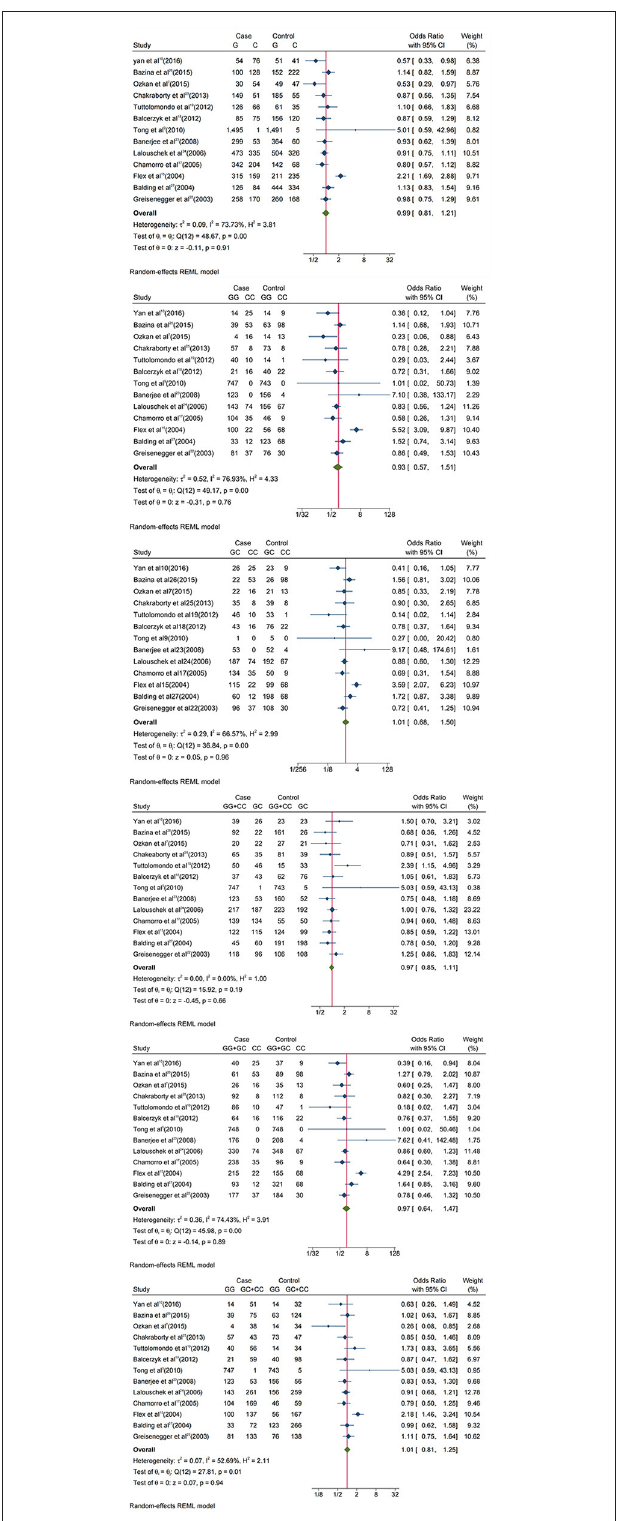
FIGURE 2 | Forest plots of Interleukin-6 − 174G/C(rs1800795) polymorphism and IS. The allelic comparison (G vs. C), homozygote comparison (GG vs. CC) and (GC vs. CC), hyperdominant (GG + CC vs. GC), recessive (GG + GC vs. CC,) and dominant (GG vs. GC +